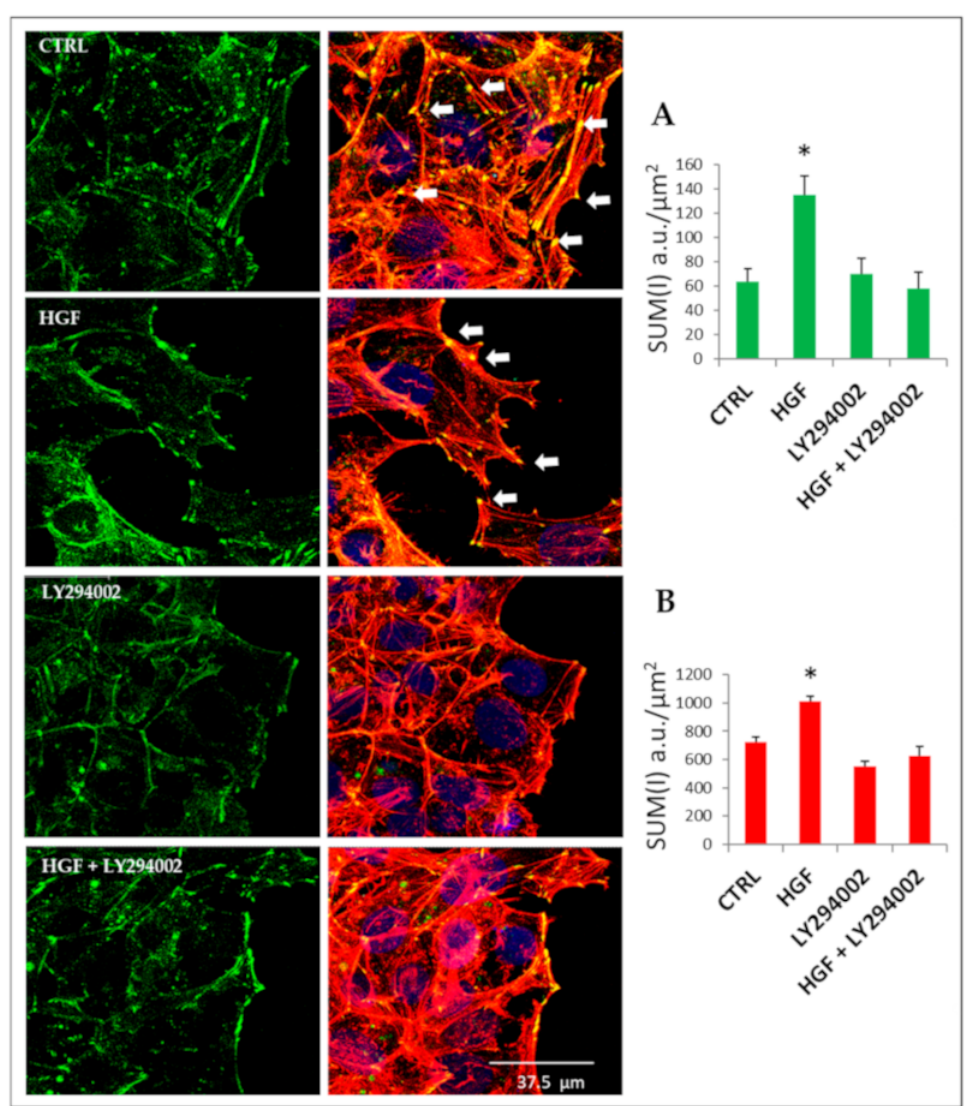
Figure 7. Left panel: representative double-fluorescence confocal images of vinculin immunostaining (green signal) and F-actin (red signal) to identify focal adhesion (FA) organization in NT2D1 cells during the wound healing experiment. Left: vinculin immunostaining (green signal); right: merged picture of vinculin with F-actin (red signal). White arrows indicate FAs. Scale bar: 37.5 µ m. Right panel: ( A ) quantitative analysis of total vinculin carried out by Leica confocal software SUM(I). ( B ) Quantitative analysis of total F-actin carried out by Leica confocal software SUM(I). (* p < 0.05); a.u. = arbitrary